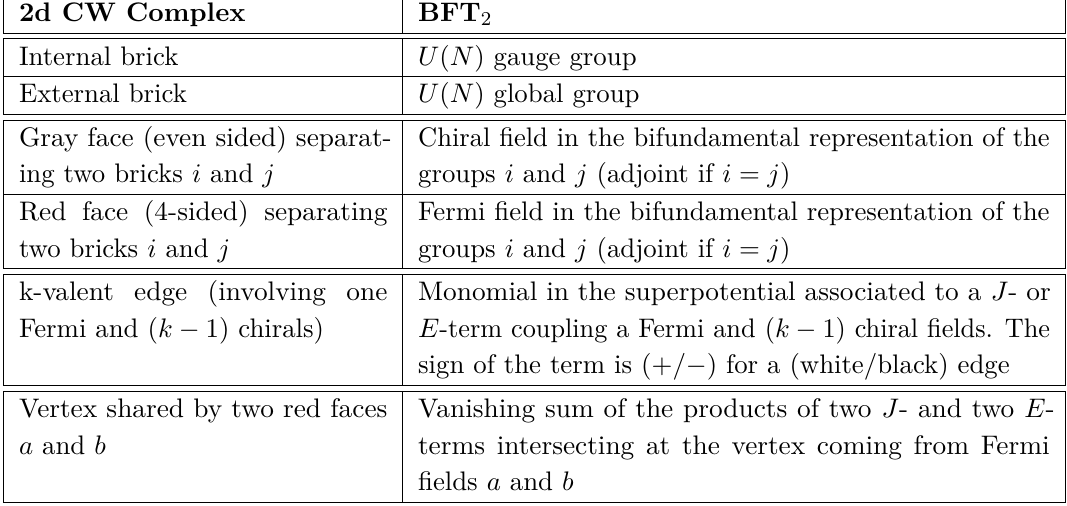
Table 1 . Dictionary between 2-dimensional CW complexes in 3-manifolds and BFT 2